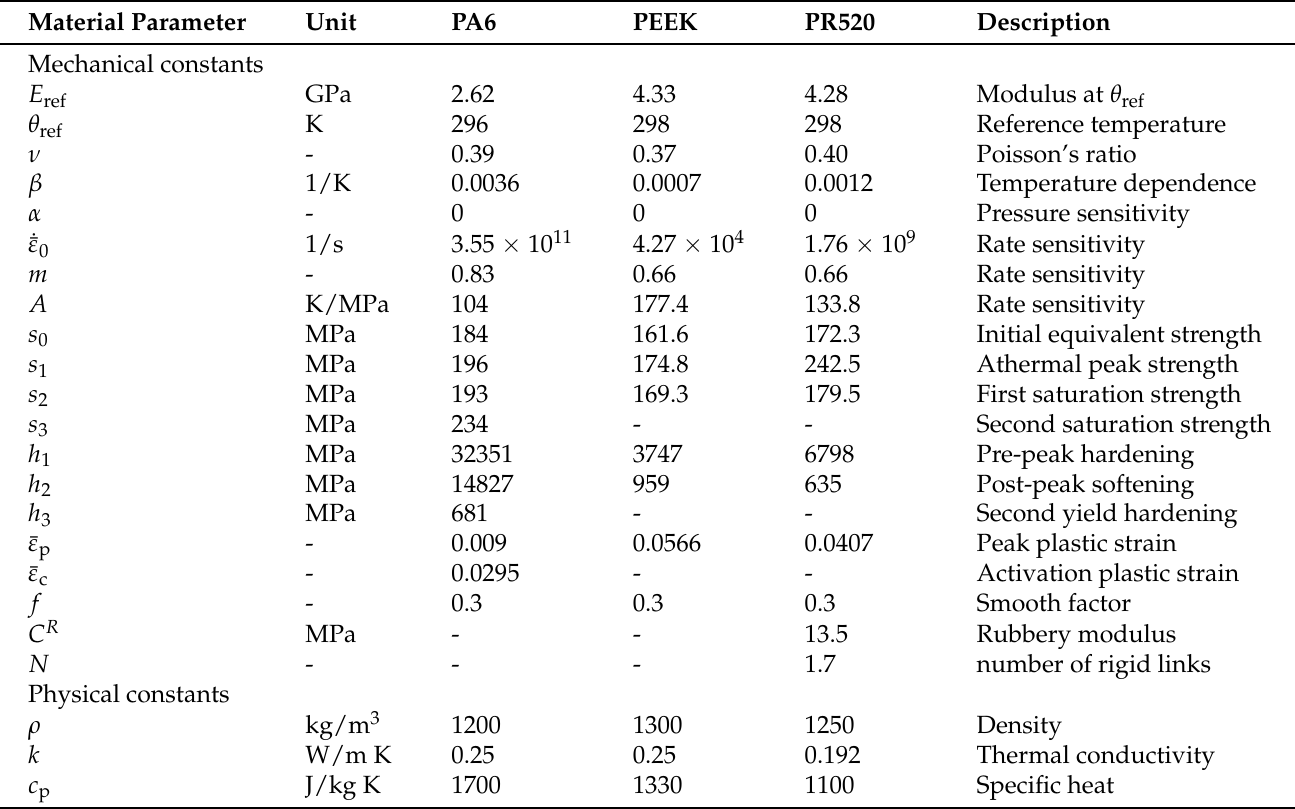
Table A1. Material parameters for the investigated PA6 [29], PEEK [30] and PR520 [30].